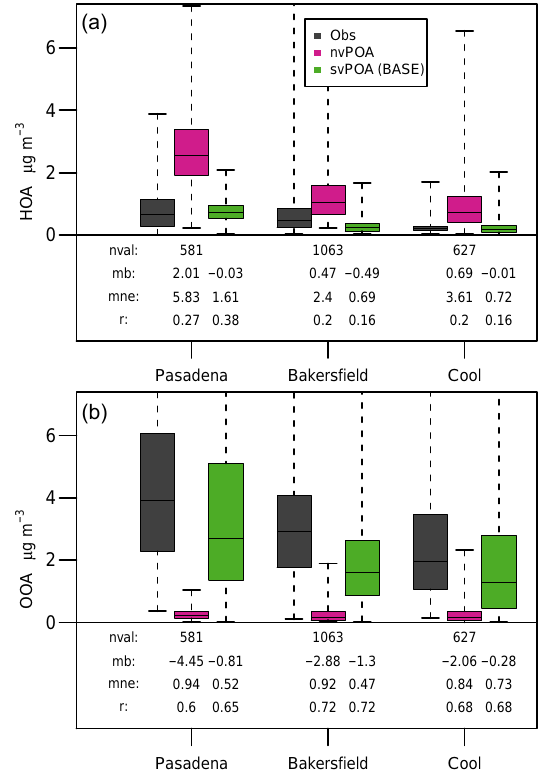
Figure 3. Comparison of OA factors derived from positive matrix factorization (PMF) of HR-ToF-AMS observations (gray) at sites in California (Pasadena, Bakersfield, and Cool). Also shown are the model-predicted concentrations of each factor at each site using the nonvolatile (pink) and base-case semivolatile (green) configu- rations. (a) compares estimations for hydrocarbon-like OA (HOA) and (b) for oxygenated OA (OOA). The boxes denote the 25th and 75th percentiles of each dataset, while the whiskers extend to the most extreme